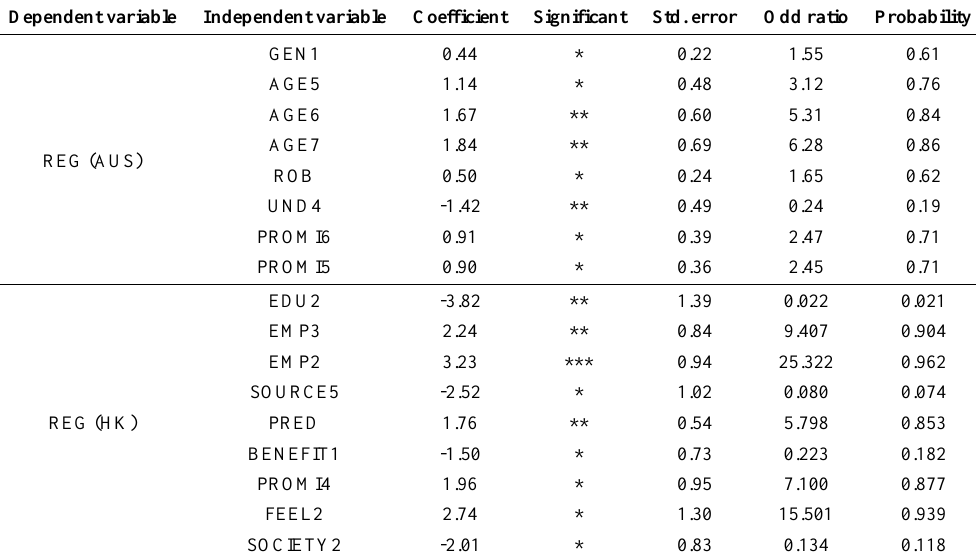
Table B- 8. Lack of regulations on AI utilization in the local government context Dependent